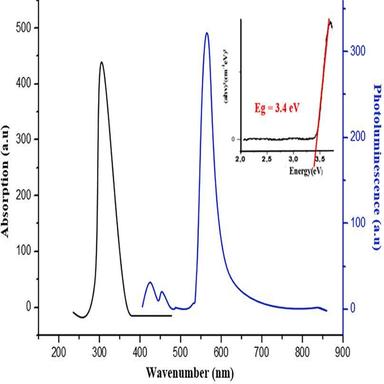
UV–Visible optical absorption (a) and Photoluminescence (b) spectrum with Tauc plot (assumed direct bandgap) of (C8H12N)42.